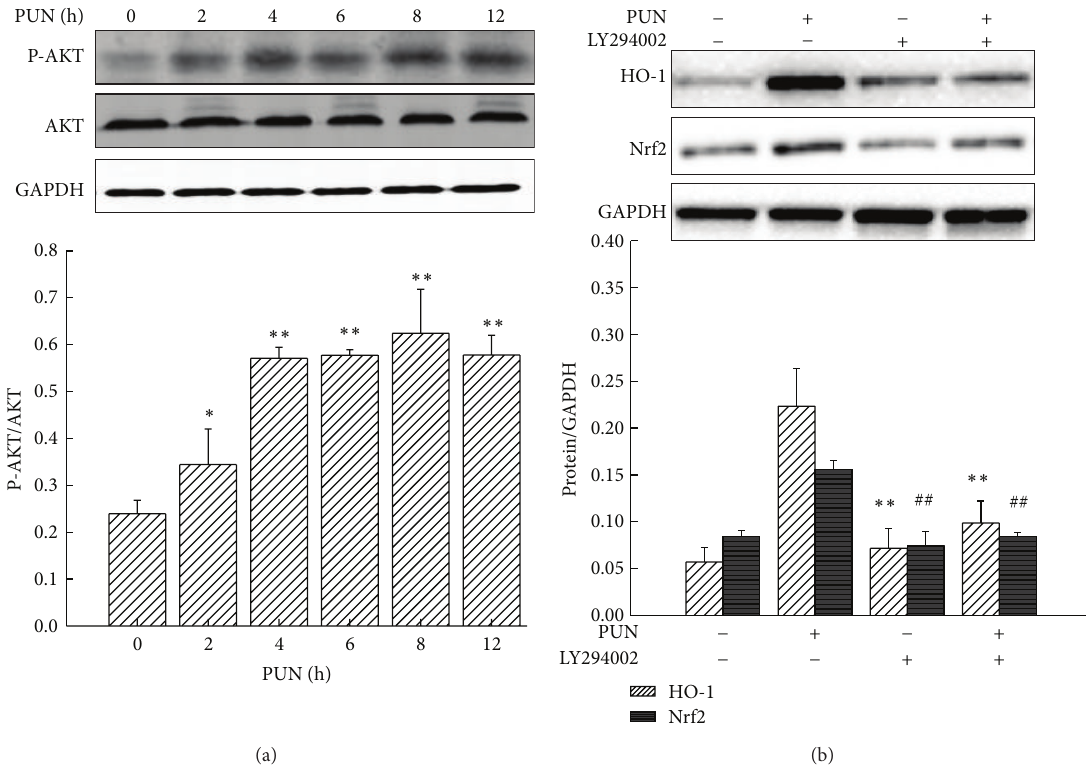
Figure 3: PUN induced HO-1 protein expression via PI3K/Akt pathway. Cells were incubated at 37 ∘ C in a humidified incubator with 5% CO 2 . (a) RAW264.7 cells were treated with 100 𝜇 M PUN for indicated durations (0, 2, 4, 6, 8, and 12h). The Akt protein and Akt phosphorylation level were analyzed by Western blotting. (b) RAW264.7 cells were treated for 8h with 100 𝜇 M PUN in the presence or absence of 20 𝜇 M LY294002. The HO-1 and Nrf2 proteins expression were analyzed by Western blotting. Data represent the mean ± SEM of three independent experiments and differences between mean values were assessed by one-way ANOVA. ∗∗ 𝑃 < 0.01 and ## 𝑃 < 0.01 indicate significant differences compared with the PUN-treated group of indicated proteins,